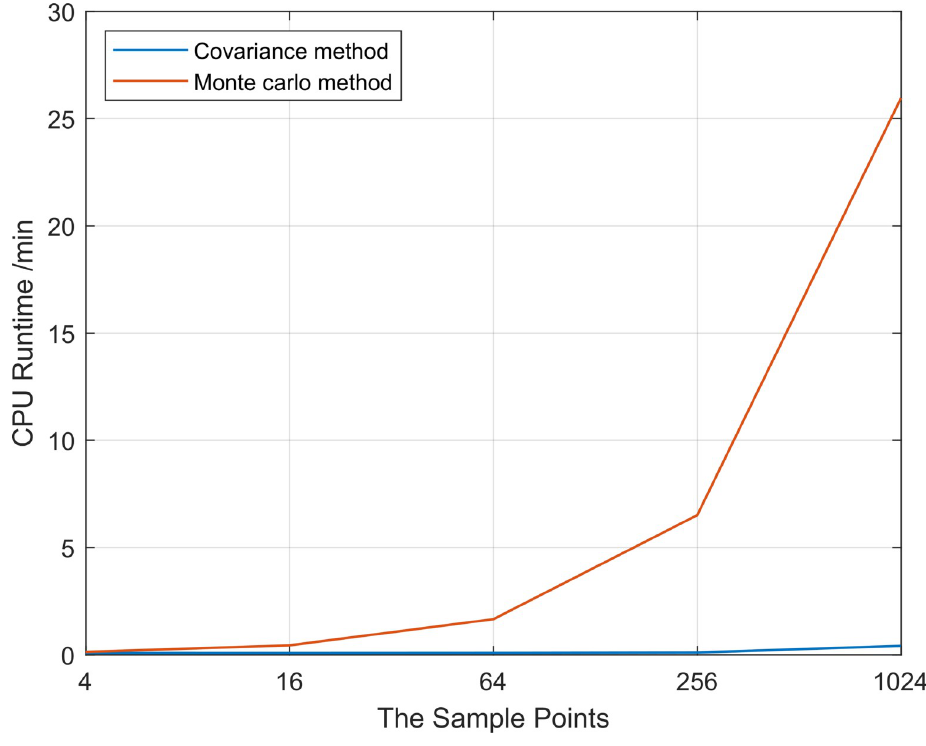
Fig 12. Comparison of CPU